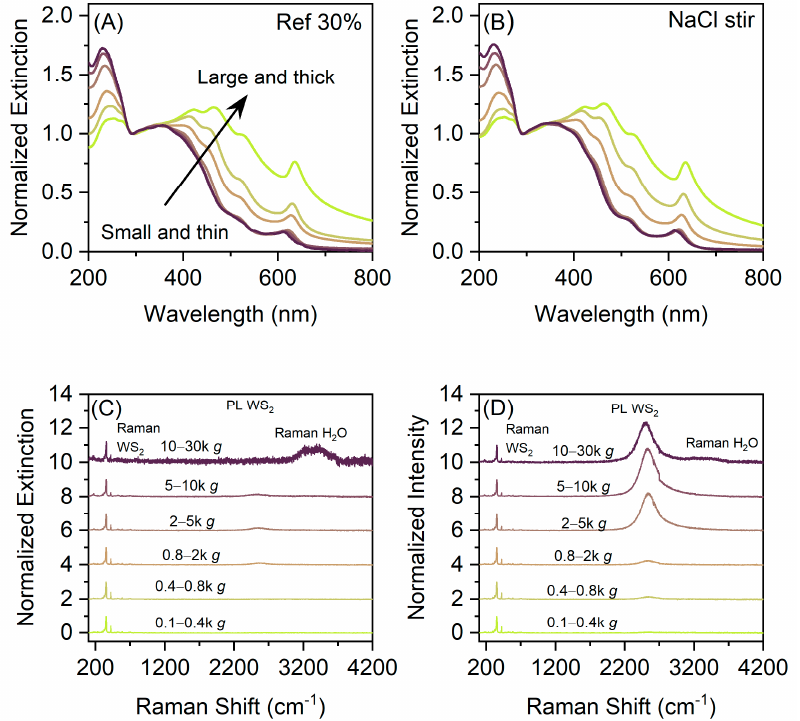
Figure 2. Spectroscopic characterization of the size-selected dispersion. ( A , B ) Normalized extinction spectra of the reference exfoliated with an amplitude of 30% ( A ) and the sample set corresponding to the WS 2 exfoliated with 30% amplitude after pretreating the powder by stirring in NaCl ( B ). ( C , D ) Normalized Raman spectra (532 nm excitation) of the reference ( C ) and NaCl-pretreated sample ( D ). Spectra are offset for clarity.